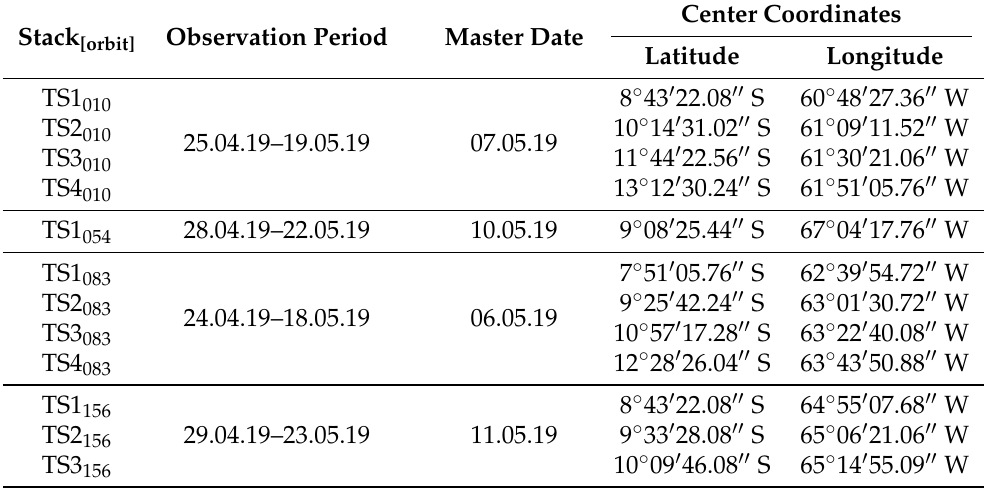
Table 2. Description of the 12 Time Series (TS) stacks, their relative orbits, acquisition dates, and corner coordinates of the